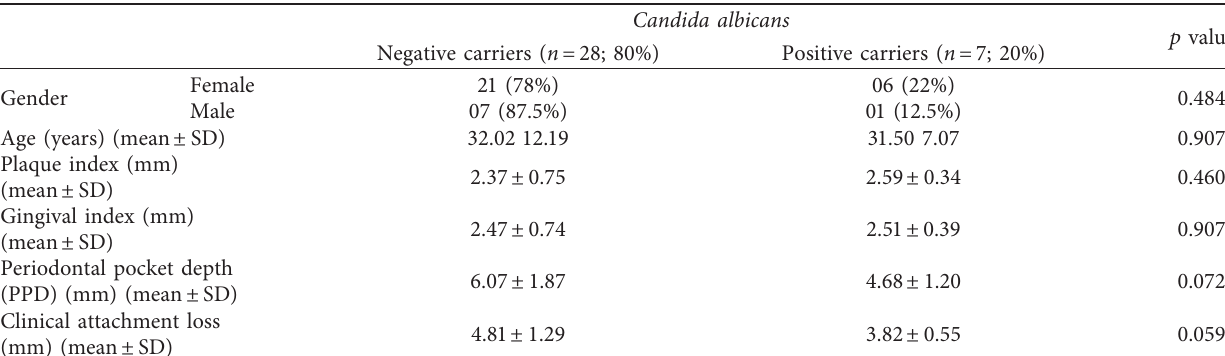
Figure 3: Agarose gel electrophoresis of PCR products of Candida albicans isolates. Table 4: The presence of Candida albicans among the study population according to periodontal